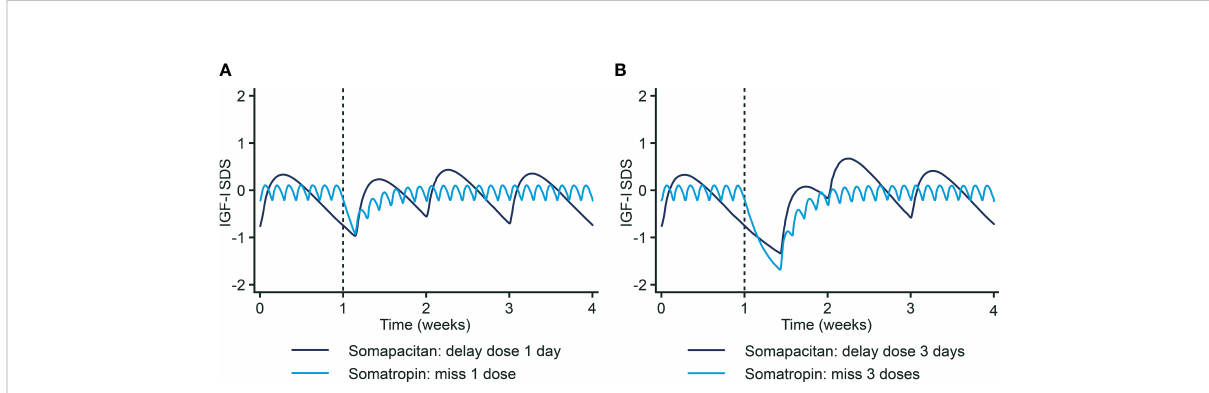
FIGURE 2 IGF-I SDS pro fi les following missed doses of somapacitan and somatropin. (A) One missed dose day. (B) Three missed dose days. Reprinted from Juul Kildemoes et al. (16) under the CC-BY license (https://creativecommons.org/licenses/by/4.0/). IGF-I, Insulin-like growth factor I. SDS, Standard deviation score.